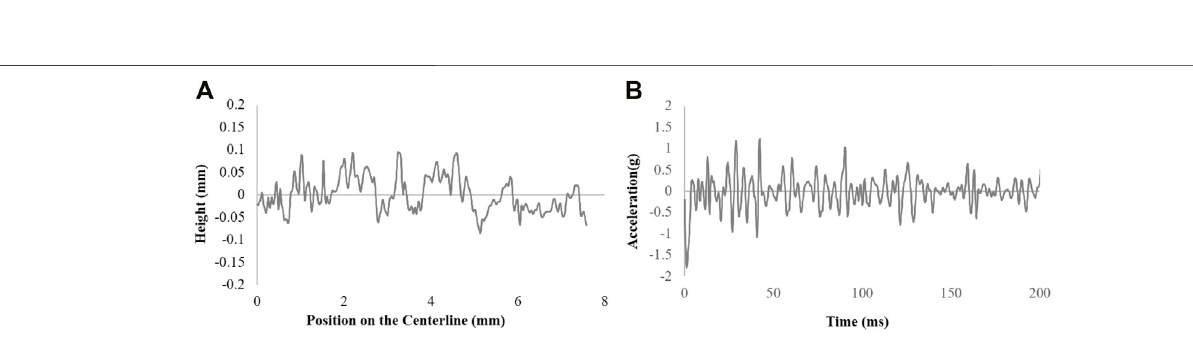
Frontiers in Virtual Reality |